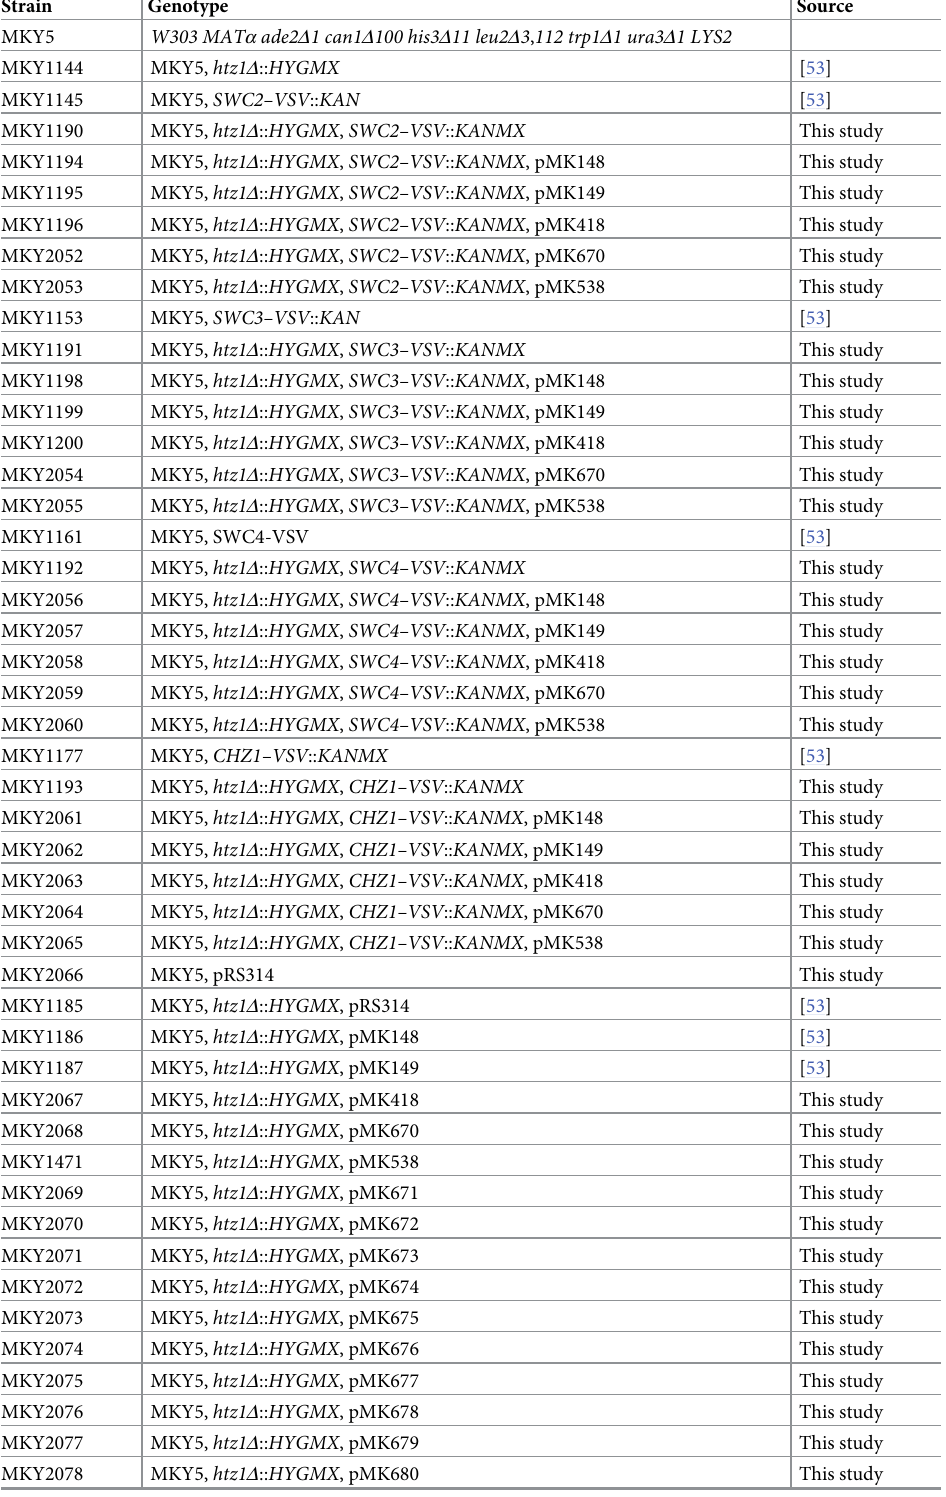
Table 1. Yeast strains used in this